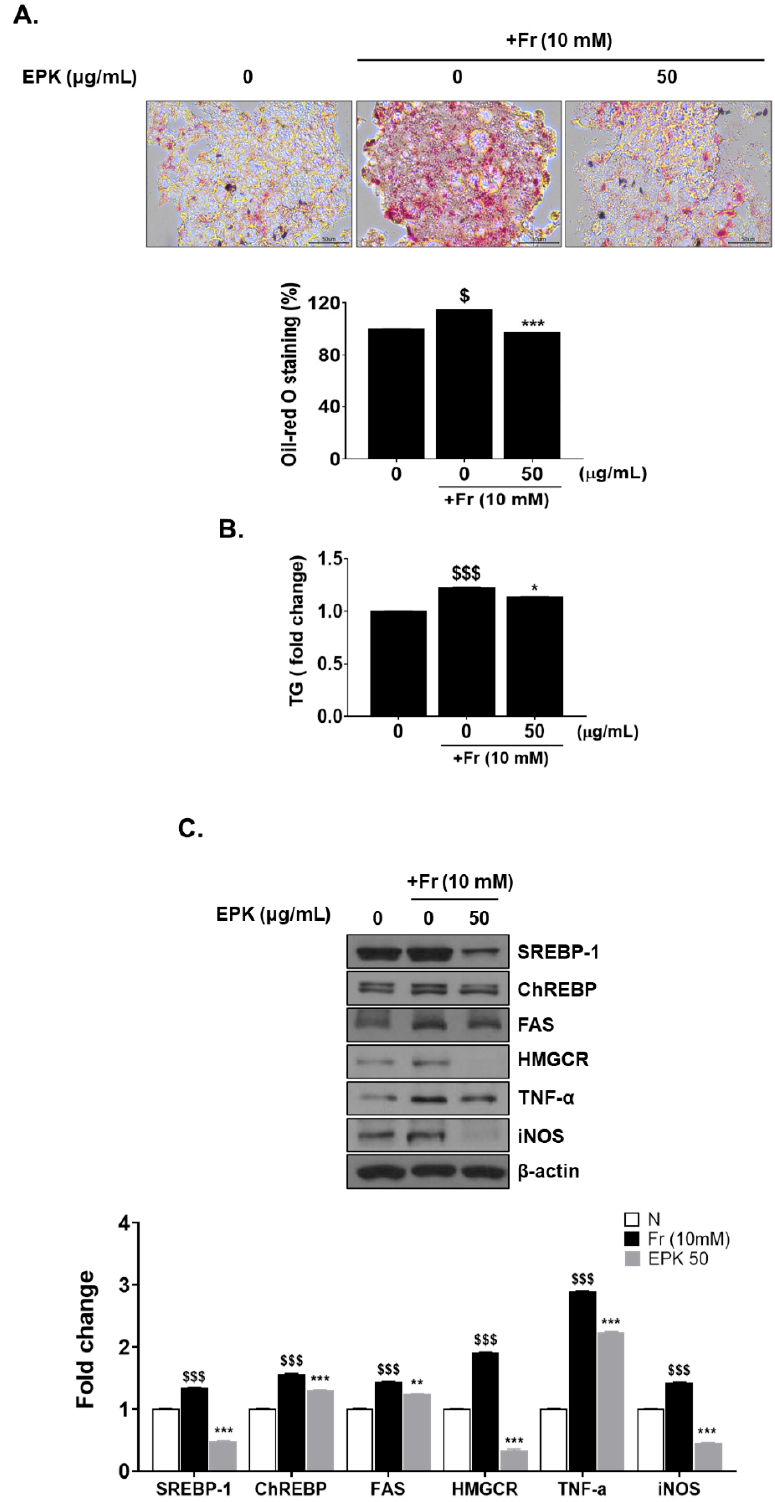
Figure 3. Effect of EPK on lipid synthesis in high-fructose (HF)-induced HepG2 cells. HepG2 cells were pretreated with 10 mM fructose for 48 h, and then EPK (50 µ g/mL) and fructose (10 mM) were treated on the HepG2 cells for 24 h. ( A ) Effect of EPK on lipid accumulation in fructose-induced HepG2 cells. An Oil-Red-O-stained cell represents an accumulation of lipid. The graph showed a percentage of cellular lipid accumulation. *** p < 0.001 versus HFrD control group. $ p < 0.05